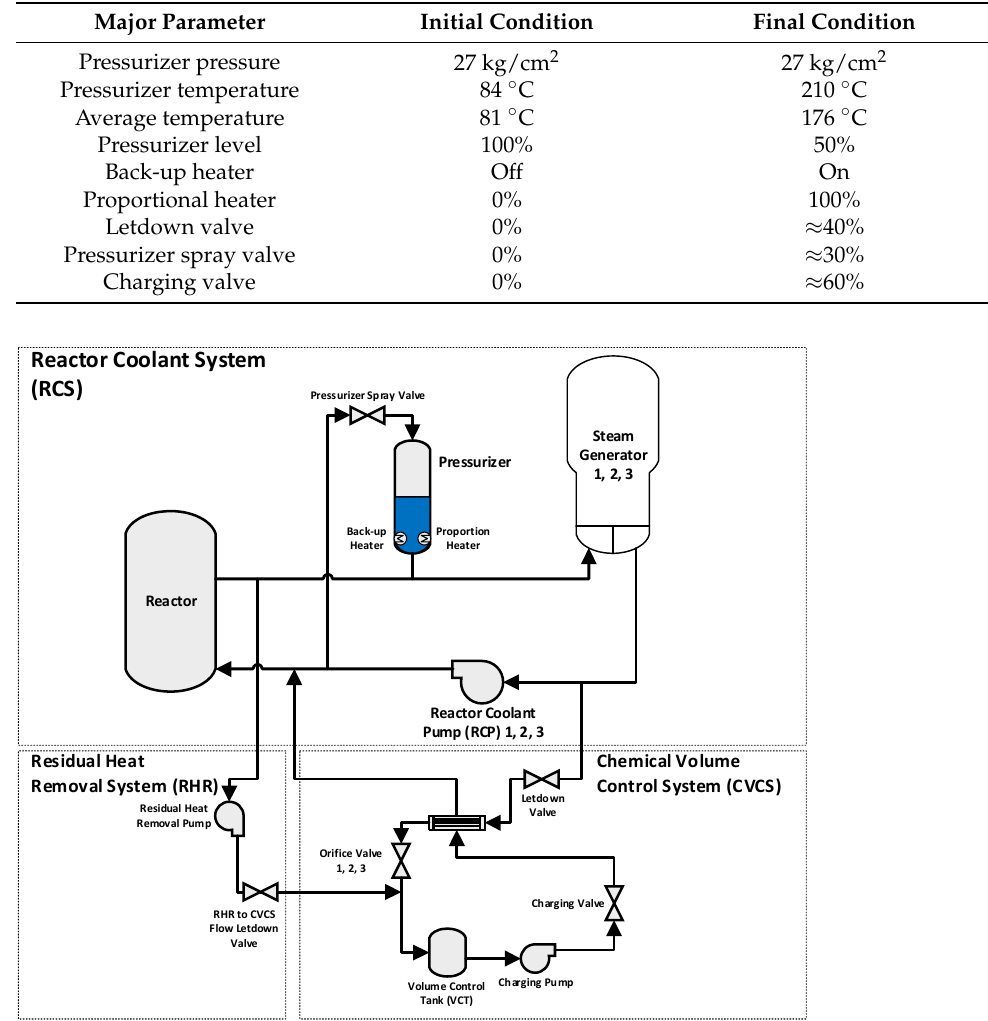
Figure 2. Simplified schematic of related components.